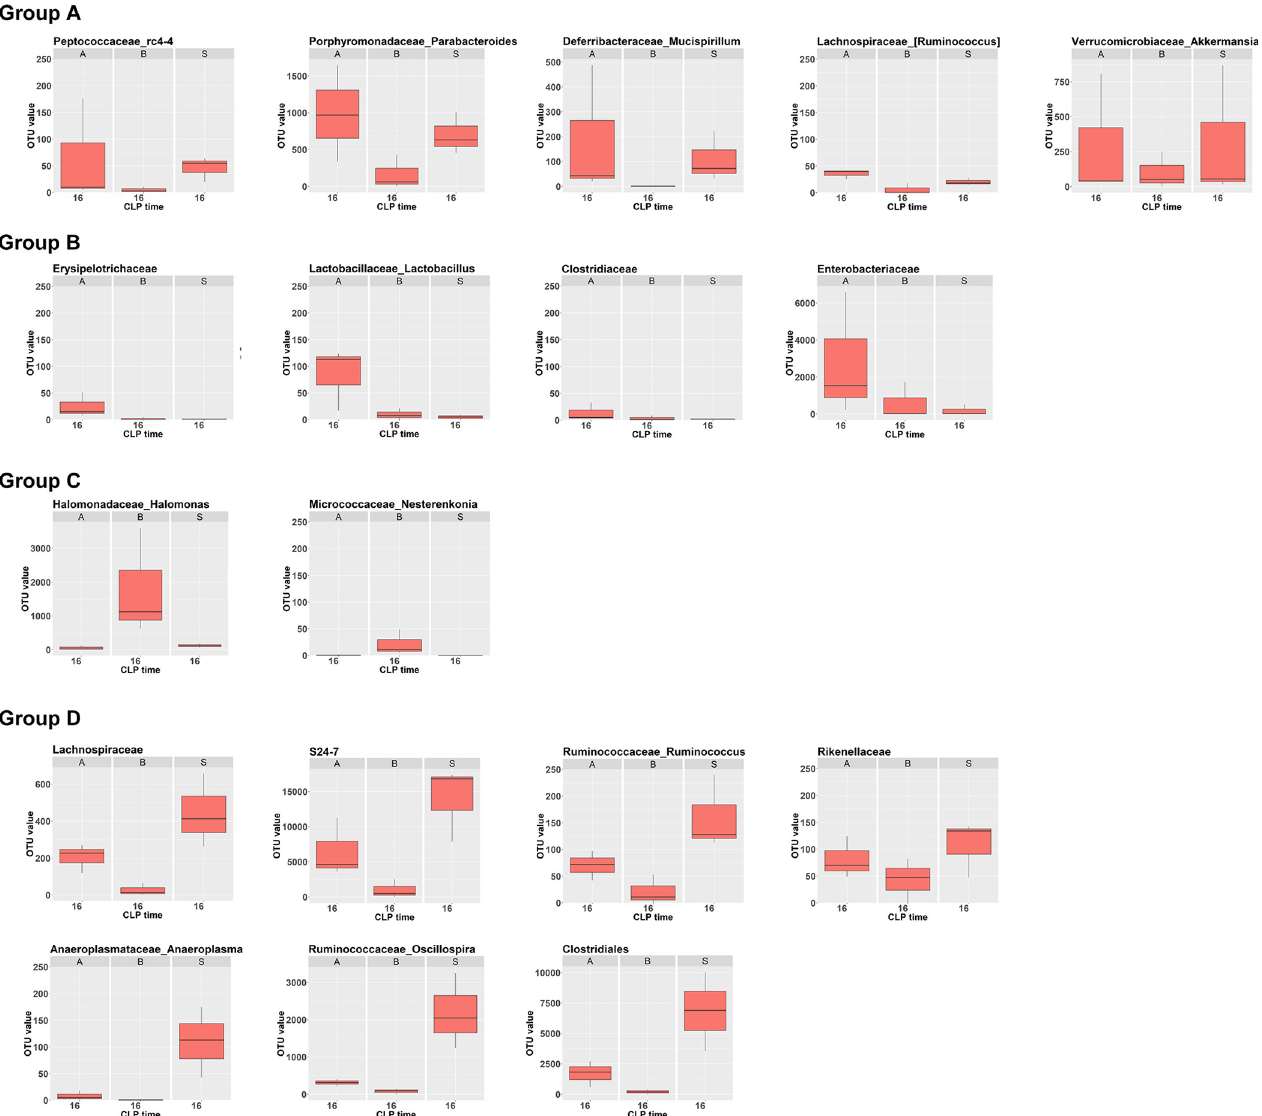
Fig 2. Hierarchical clustering of 18 bacterial taxa that had significantly different abundances among different samples of ascites, blood, and stool from the metagenomic analysis in the C57BL/6 mice.